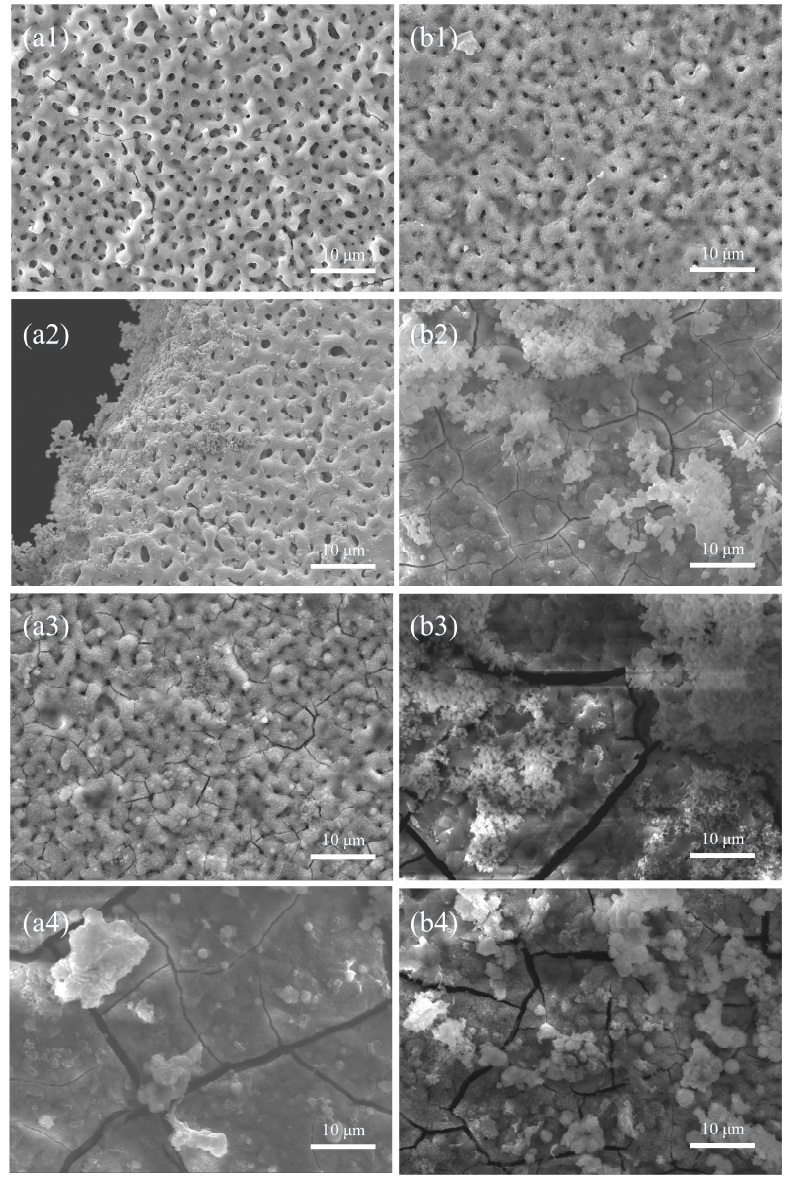
Figure 9. SEM patterns of di ff erent coatings after immersion in SBF. 0 days: ( a 1 )